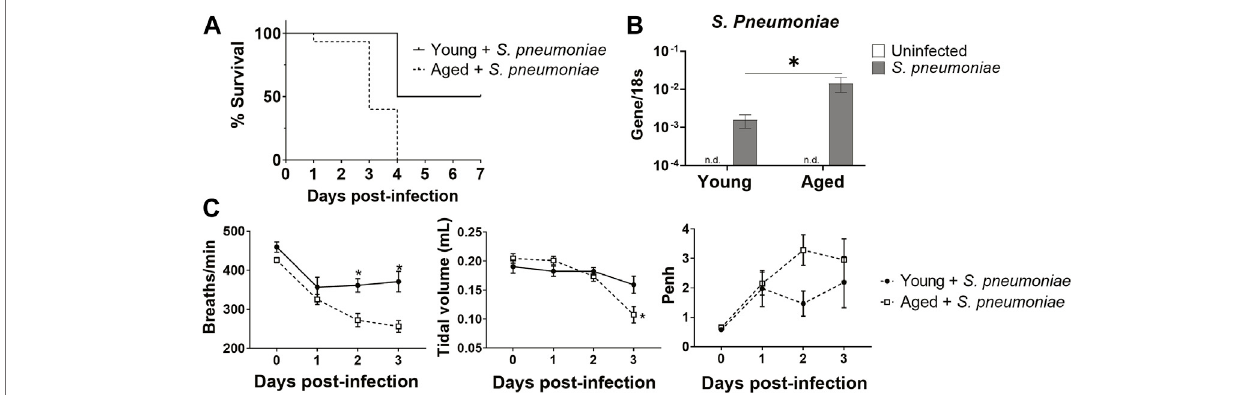
FIGURE 1 | Aged mice have increased susceptibility to intranasal S. pneumoniae infection compared to young mice. (A) Survival curve for young and aged mice after intranasal infectionwith S.pneumoniae. * p < 0.05byLog-rank test. n=10 – 15animalsper group. (B) PCRfor S.pneumoniae DNAinlungs isolatedfromuninfected or 24 h after S. pneumoniae infection in young and aged mice. Error bars indicate mean ± SEM. * p < 0.05 by t test. n = 3 – 15 mice per group. n. d. = not detected. (C) Respiratory functions of breath frequency (breaths/minute), tidal volume (ml) and enhanced pause (Penh) were measured in young and aged-infected animals by unrestrained whole-body plethysmography. * p < 0.05 by t test. n = 8 – 14 animals per group.